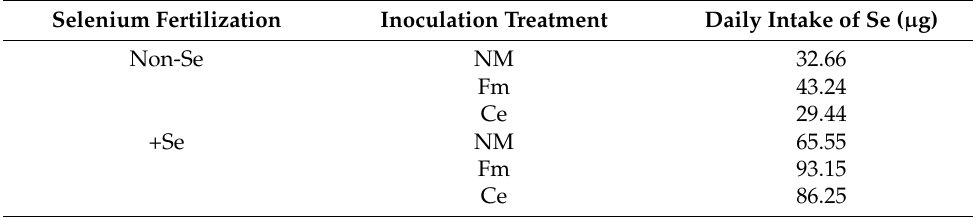
Table 4. Daily intake of Se ( µ g) for adults from soybean. Selenium